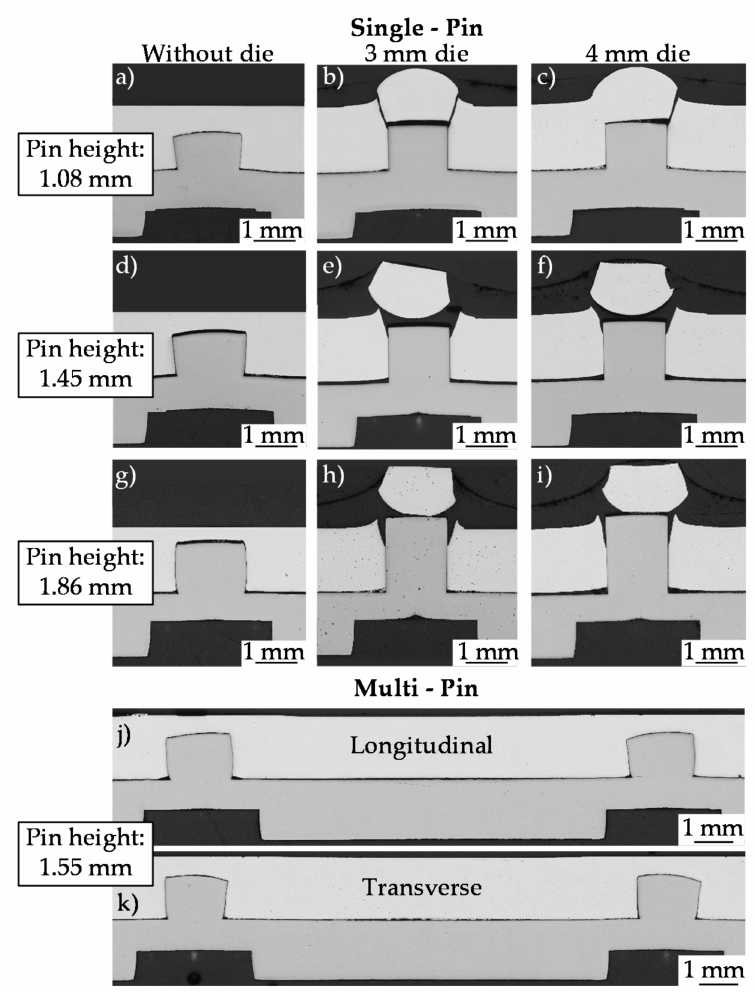
Figure 10. Micrographs of the investigated joint variations. ( a ) 1.08 mm pin joined without die, ( b ) 1.08 mm pin joined with 3 mm die, ( c ) 1.08 mm pin joined with 4 mm die, ( d ) 1.45 mm pin joined without die, ( e ) 1.45 mm pin joined with 3 mm die, ( f ) 1.45 mm pin joined with 4 mm die, ( g ) 1.86 mm pin joined without die, ( h ) 1.86 mm pin joined with 3 mm die, ( i ) 1.86 mm pin joined with 4 mm die, ( j ) 1.55 mm longitudinal multi pins and ( k ) 1.55 mm transverse multi